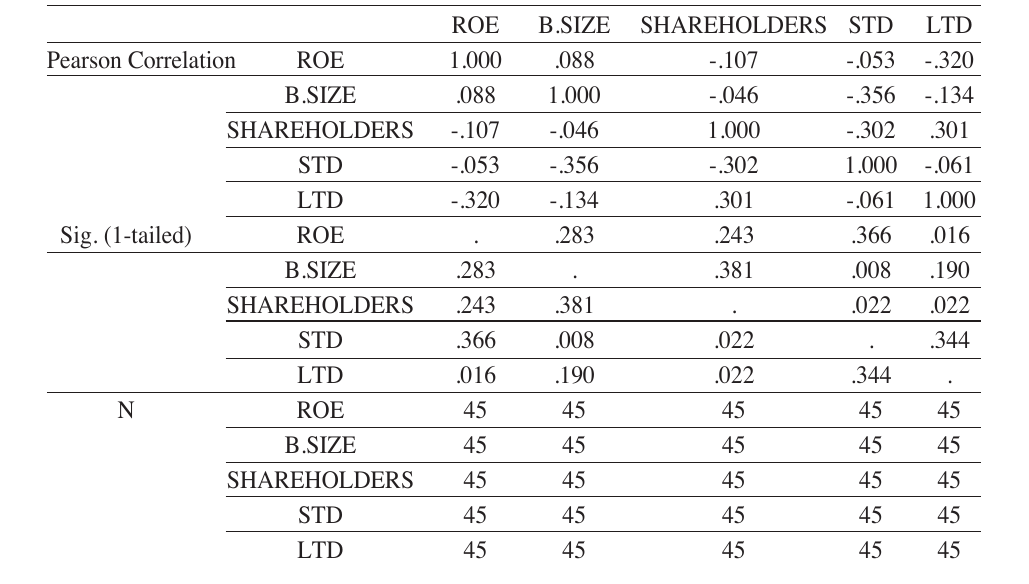
Table 6: Correlation Analysis